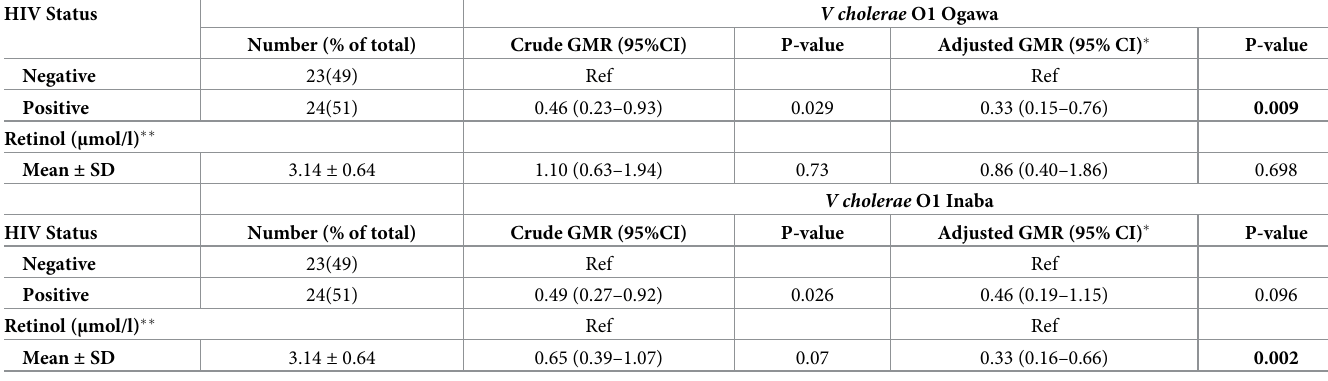
value = 0.698) while for Inaba the doubling of retinol level resulted into a significant reduction in GMR (GMR = 0.33; 95%CI: 0.16, 0.66; p-value = 0.002) (Table 2).